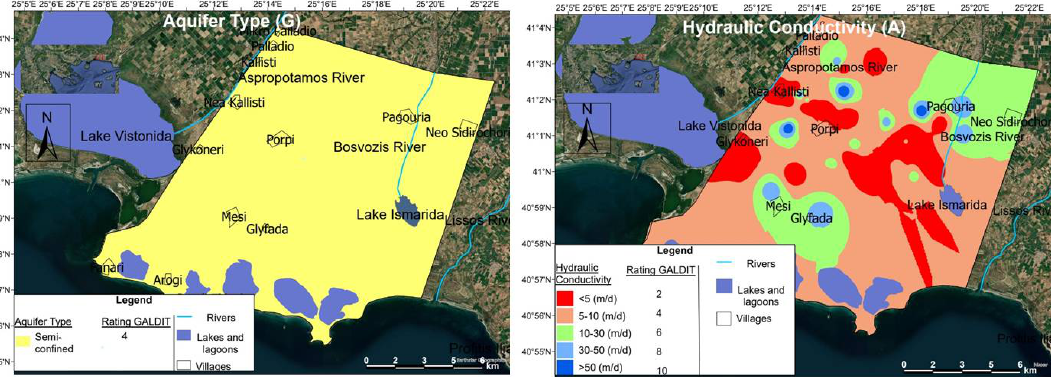
Figure 7. Thematic maps for the type of the aquifer (G) ( left ) and the hydraulic conductivity (A) ( right ) for the modified GALDIT method.